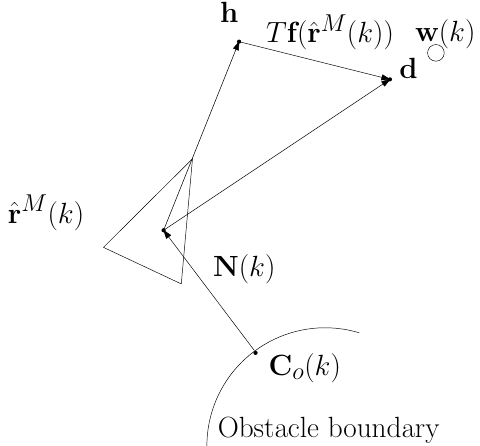
Figure 2. An illustration of concepts used in the guidance controls. The triangle centered at ˆ r M ( k ) shows the attitude of the moving robot. In this figure, C o ( k ) is depicted on the obstacle boundary. In addition, N ( k ) is plotted as an arrow emanating from C o ( k ) . Suppose that the robot heads towards h in this figure. Due to underwater currents, the robot moves towards d instead of h . This implies that the robot moves towards the waypoint w ( k ) , which is depicted as a